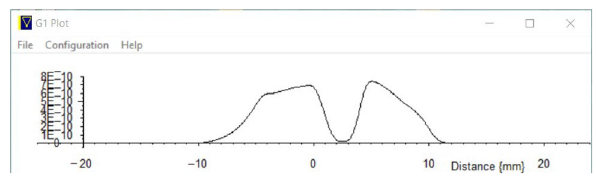
Fig. 19 A 1 dimensional projection image of a structured rubber sample in a linear gradient